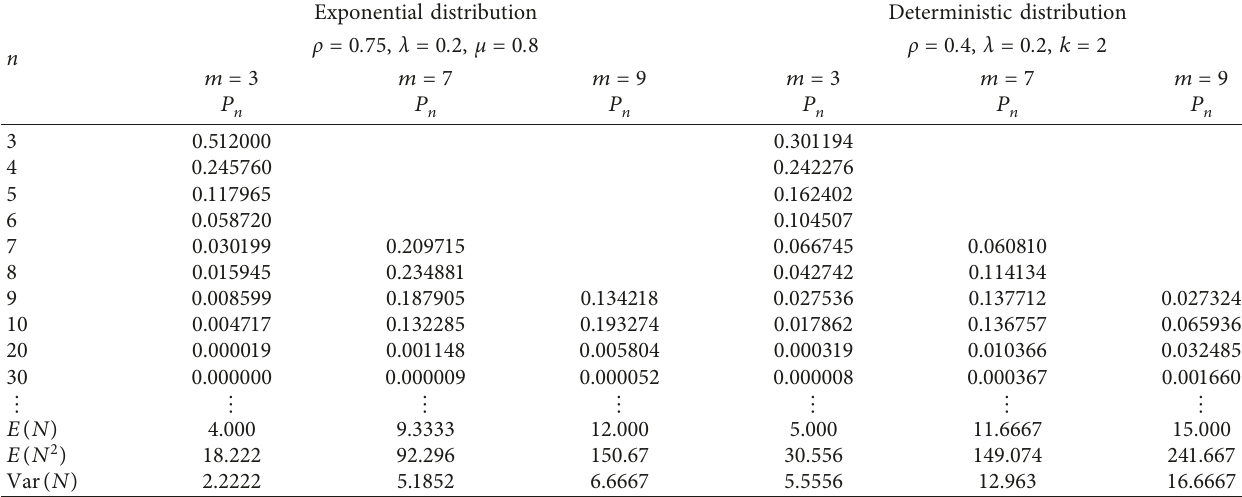
Table 1: Distribution of the number of customers served during a busy period.